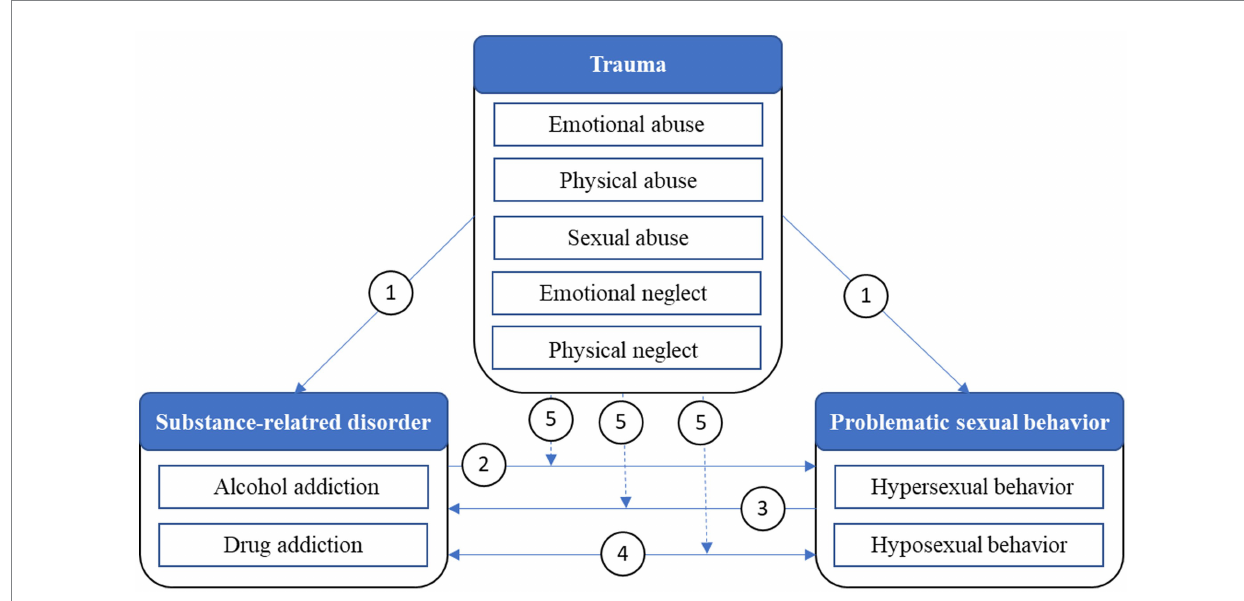
FIGURE 1 Possible relations between substance-related disorders, problematic sexual behaviors, and traumatic